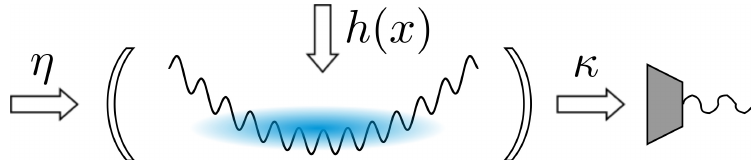
Figure 1. Schematic of the BEC–cavity system. The single-mode cavity can be pumped on axis at rate η , while the BEC inside the cavity can be pumped directly by a transverse beam of profile h ( x ) . The photons leaking from the cavity (at a rate 2 κ ) are continuously monitored. The atoms are subject to an external trapping potential V ( x ) that is illustrated by the black line. Here the potential is shown mimicking a superposition of a periodic optical lattice and a harmonic trap, but generally the potential can take an essentially arbitrary